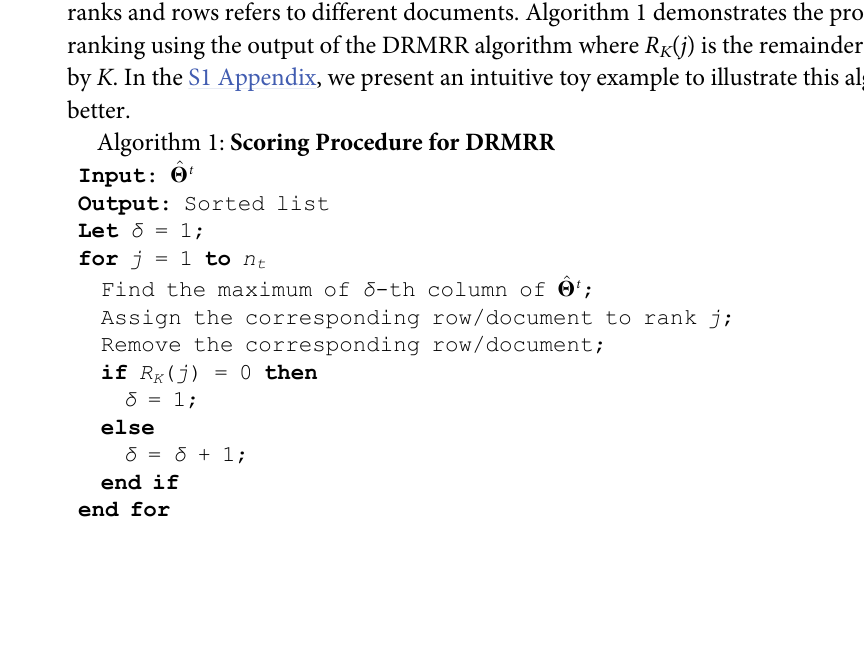
Algorithm 1: Scoring Procedure for